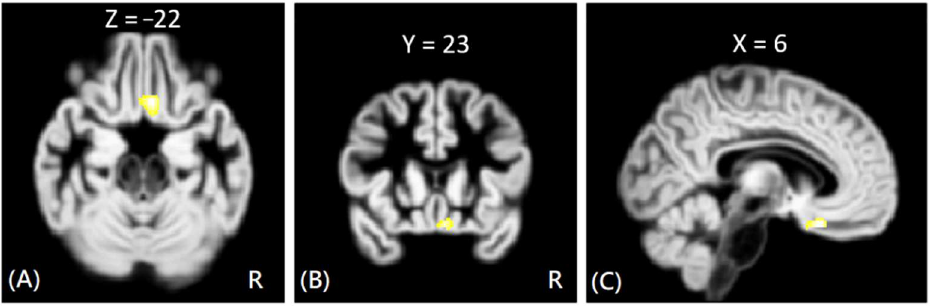
Figure 3. The voxel-wise DTI analysis of AD values between VP and HC groups. The yellow-white color indicates significantly increased AD values in the VP group in the right rectus gyrus. The images are shown in axial ( A ), coronal ( B ), and sagittal views ( C ).